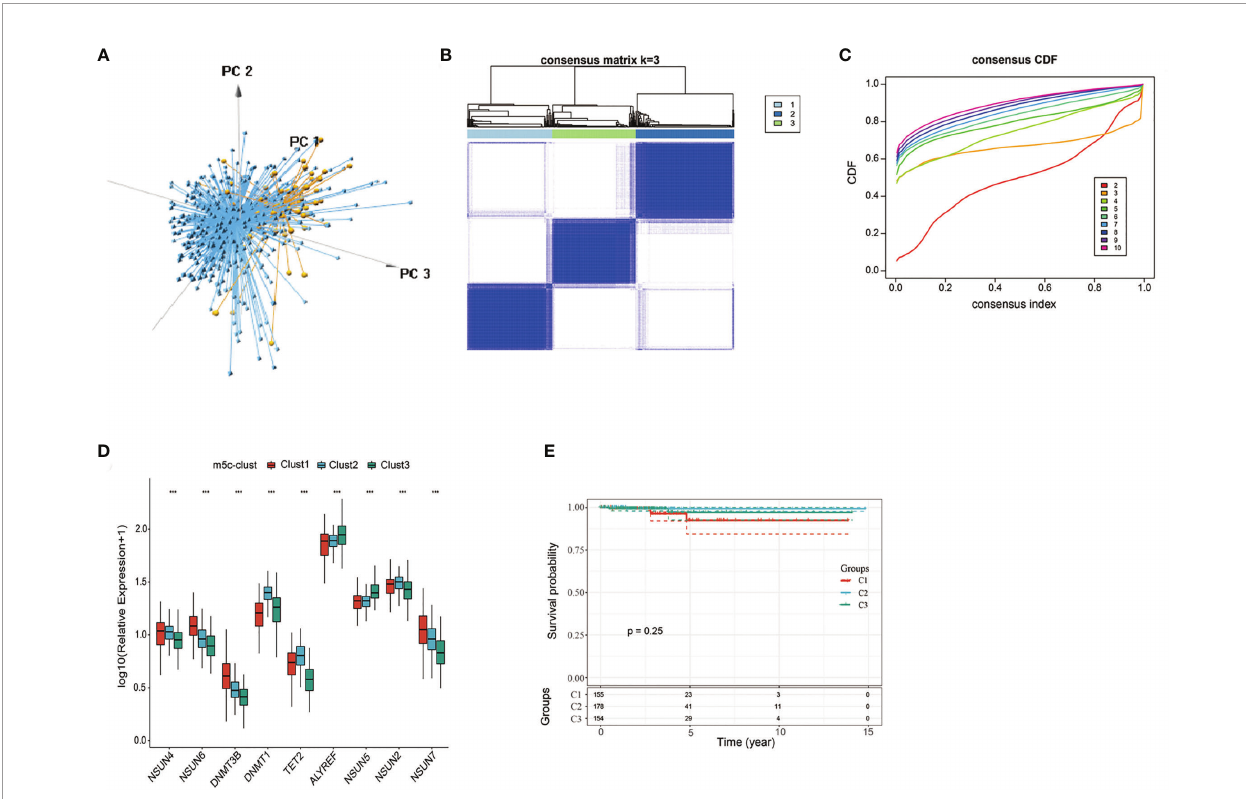
FIGURE 1 | The nine-regulator-mediated m 5 C methylation modi fi cation patterns. (A) PCA analysis based on nine m 5 C regulators. (B, C) Consensus clustering was adopted for identifying the different m 5 C modi fi cation patterns. (D) The expression levels of 9 m 5 C regulators in different m 5 C modi fi cation patterns. (E) Survival analysis of the three subtypes. ***statistical signi fi